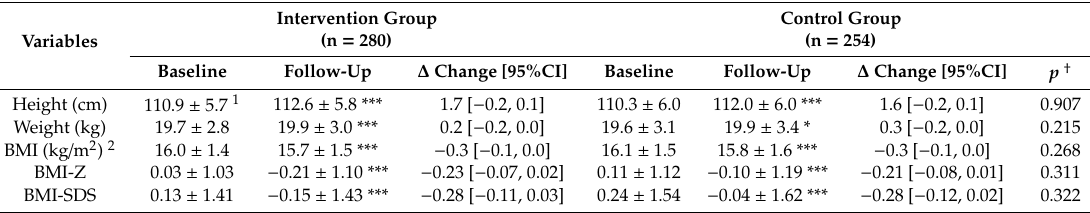
Table 2. Changes in anthropometric measurement of the preschoolers after participating in the Mission X